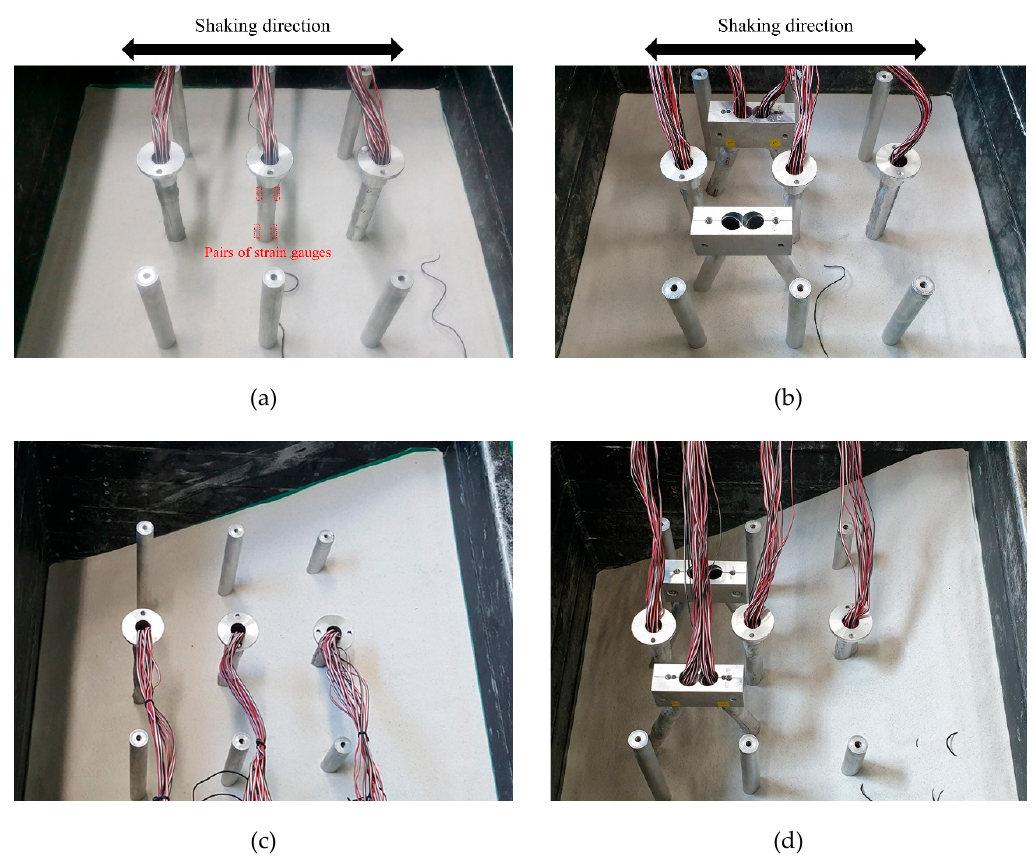
Figure 4. Plan view of experimental model before installing the deck plate: ( a ) HA45 model; ( b ) HAI55 model; ( c ) IA62 model; and ( d ) IAI58 model.